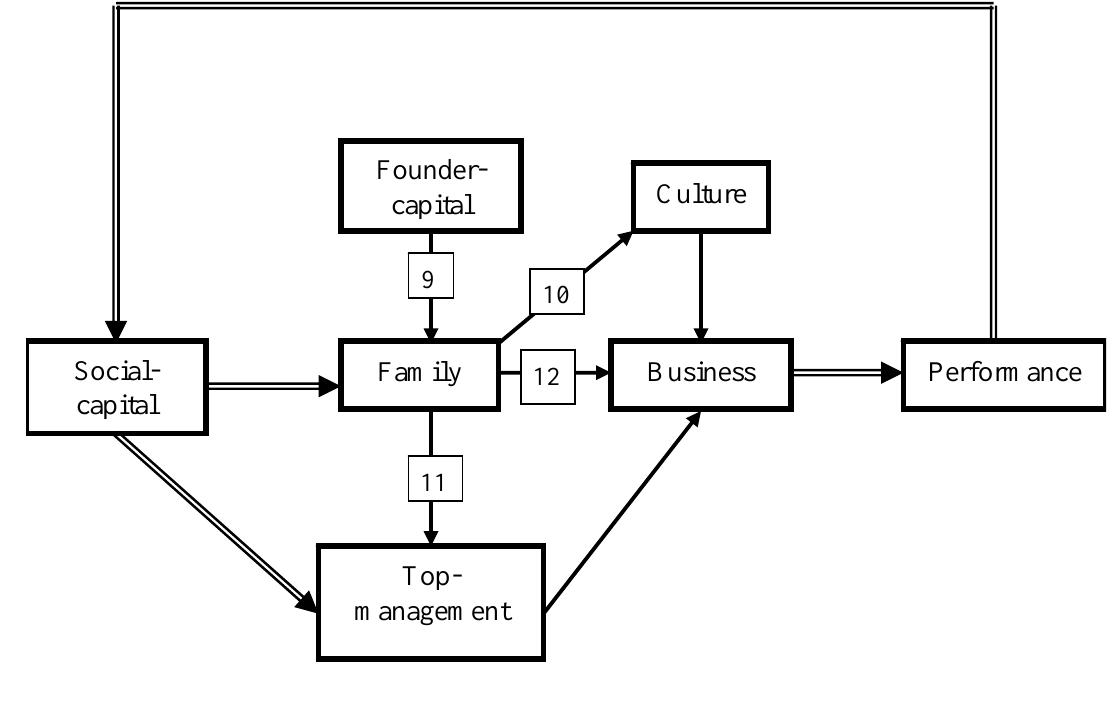
Figure 4: Creation and transmission of familiness in stage two –